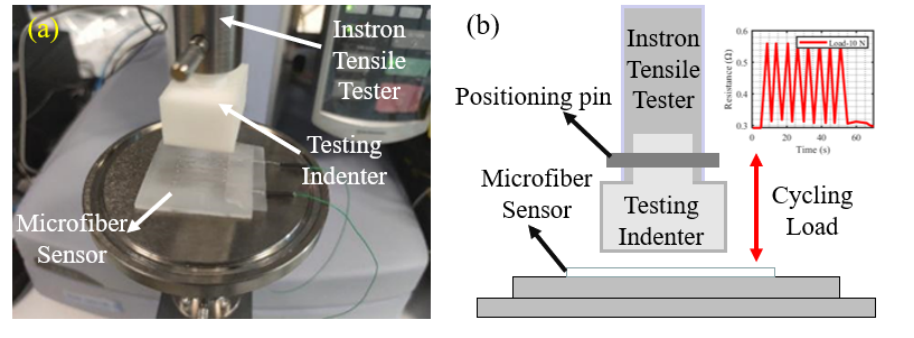
Figure 9. ( a ) The basic test setup system for the Instron tensile tester, which includes the testing indenter by 3D printing and our proposed microfiber sensor; ( b ) the working schematic of the Instron tester for the cycle load